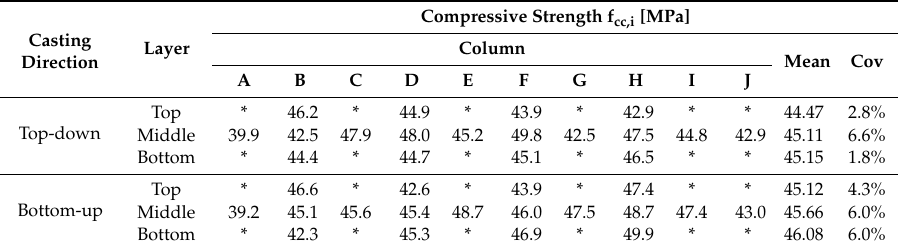
Table 4. Compressive strength test results for horizontal elements.